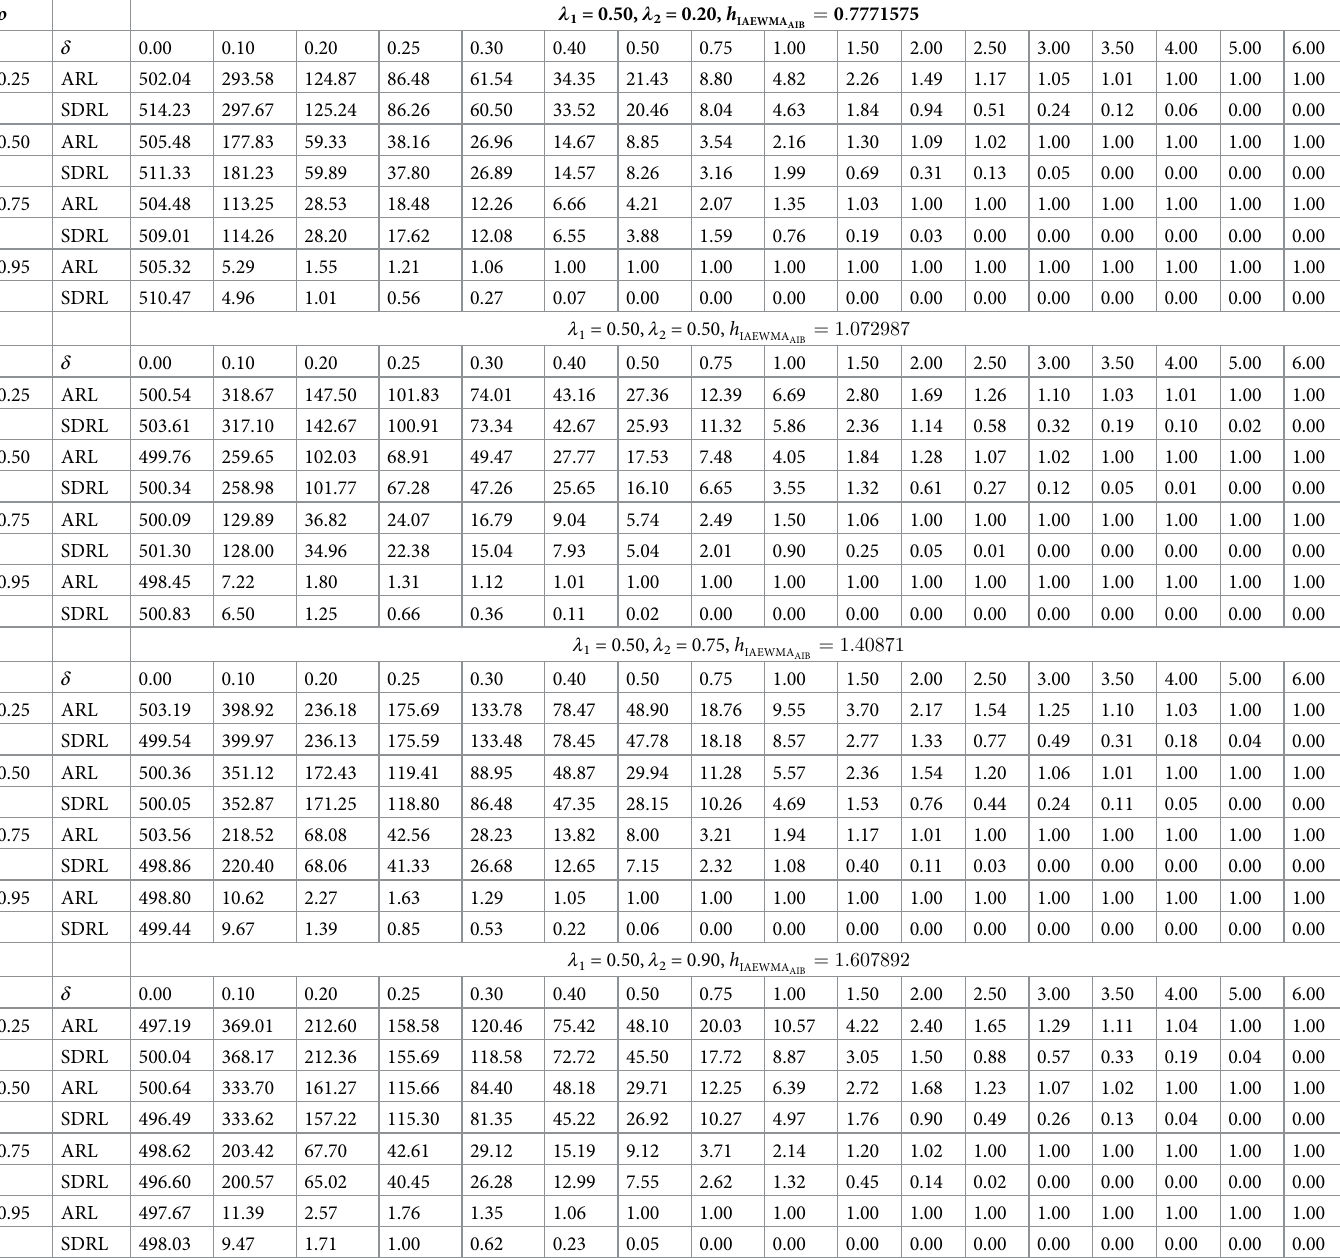
Table 3. The run-length profile of proposed IAEWMA AIB control chart under various choices of λ 2 when λ 1 is large and ARL 0 = 500.